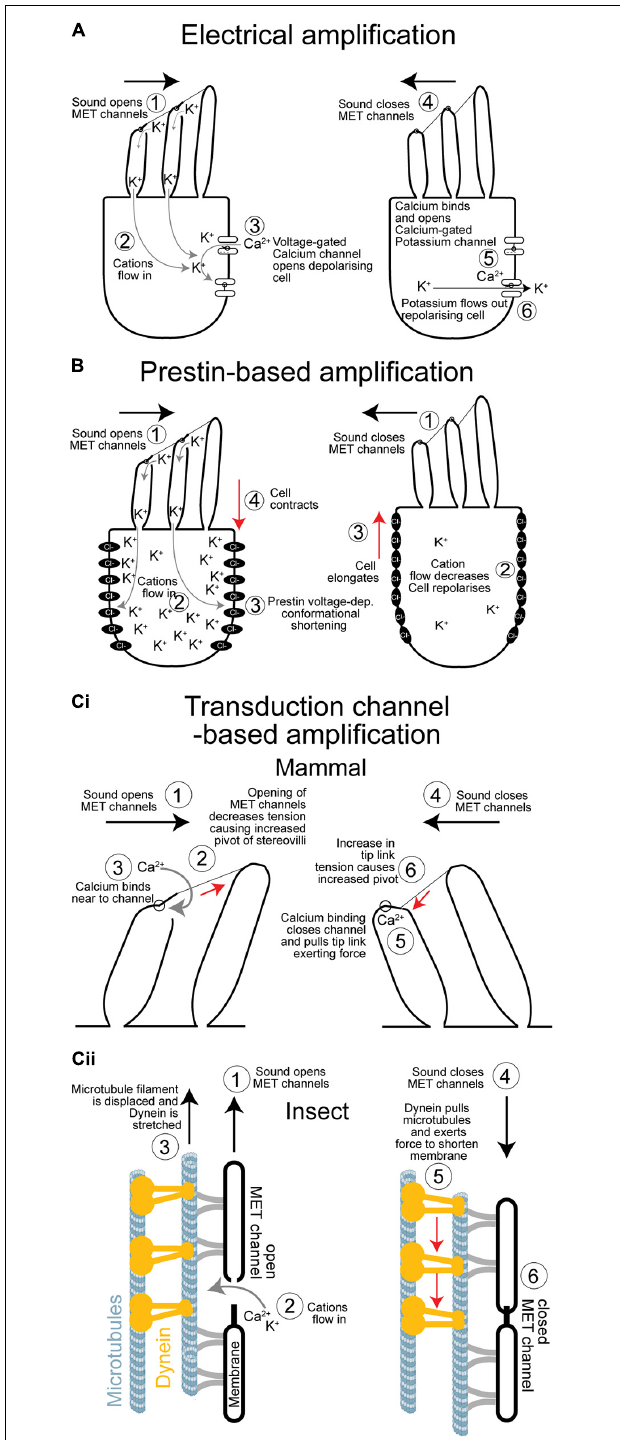
FIGURE 2 | Comparison of the three cellular mechanisms to amplify sound. (A) Electrical amplification in the frog’s sacculus is based on reciprocal feedback loop created by voltage- and calcium-gated ion channels that sets up an electrical resonance which amplifies quiet sound of relatively low frequencies. (B) Prestin-based amplification of sound exclusive to mammals.